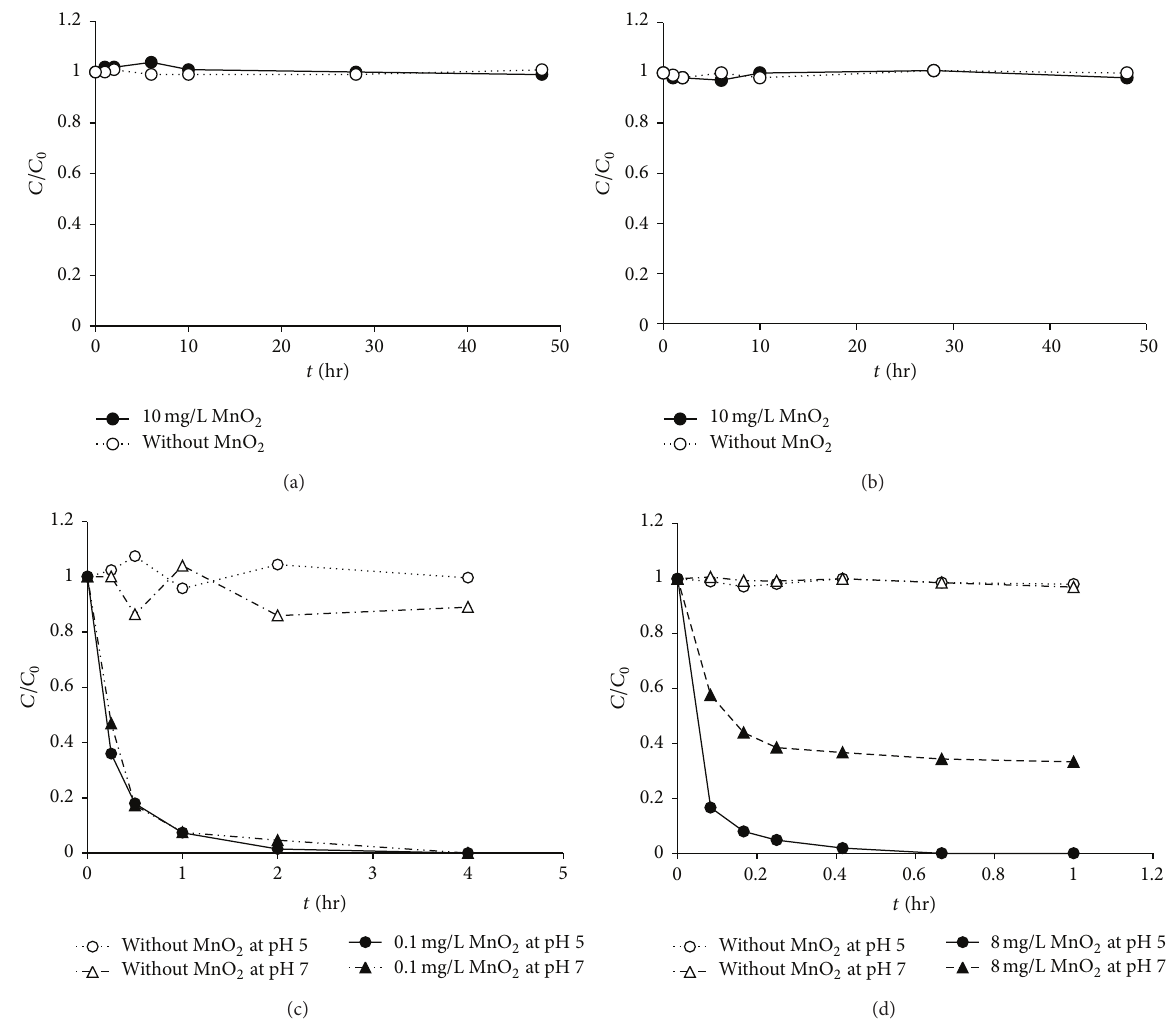
Figure 1: Oxidation of the four controlled substances by MnO 2 : (a) ketamine at pH 5, (b) methamphetamine at pH 5, (c) morphine, and (d) codeine (compound concentration = 100 𝜇 g/L, ionic strength = 10